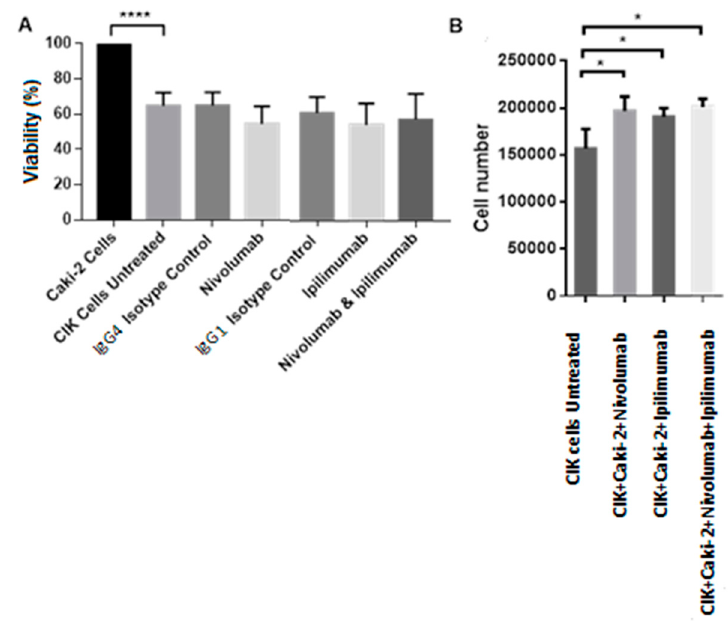
Figure 6. Effects of nivolumab and ipilimumab and control antibodies on the number of viable cells after 72 h of coculture of Caki-2 and CIK cells. n = 3 healthy donors. Absorbance values have been normalized into percentages with each untreated control representing 100%. ( A ) Coculture of CIK cells and Caki-2 in a ratio of 10:1 with 20 ug/mL nivolumab. The cell viability after treatment with nivolumab plus ipilimumab compared to untreated CIK cells, p = 0.3408. ( B ) Number of viable CIK cells after 72 h treatment with 20 ug/mL nivolumab plus 20 ug/mL ipilimumab in the presence of Caki-2 compared to untreated CIK cells, p value= 0.0206. **** represents a p value < 0.0001, * represents a p value < 0.05.